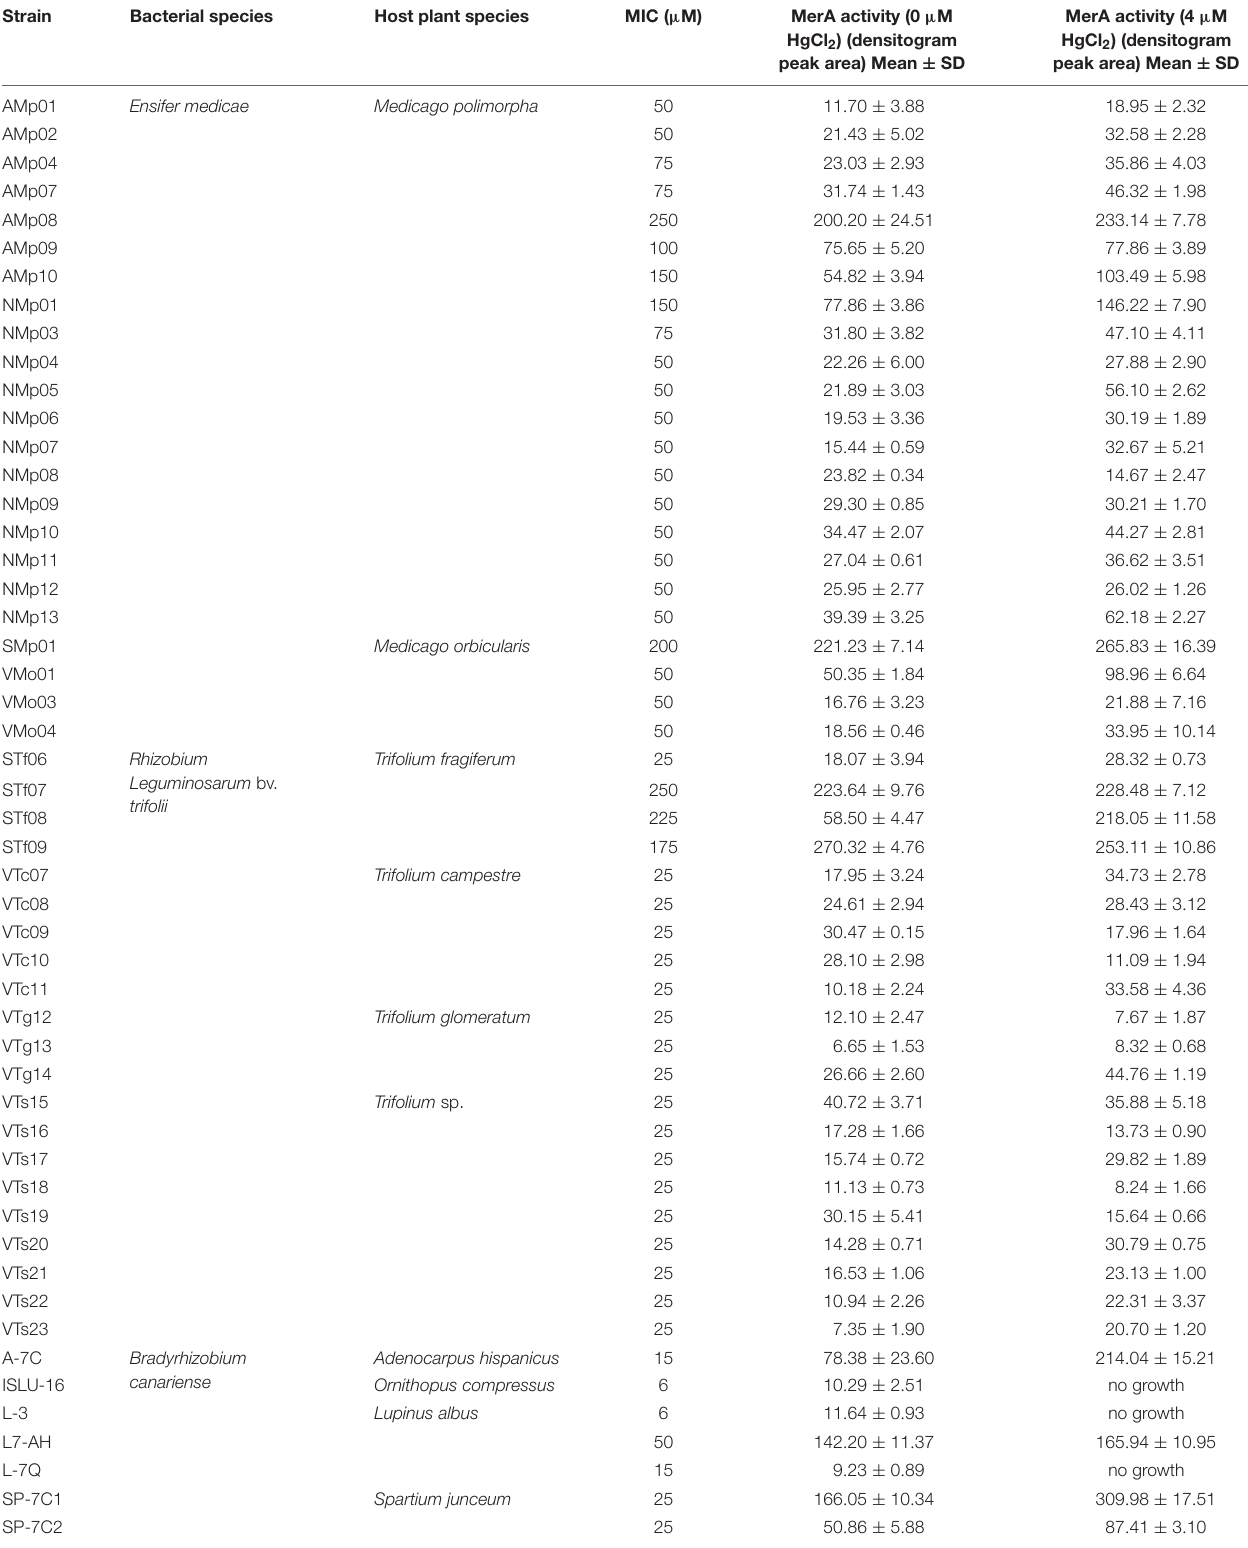
TABLE 2 | Rhizobial strains used in this study. Strain Bacterial